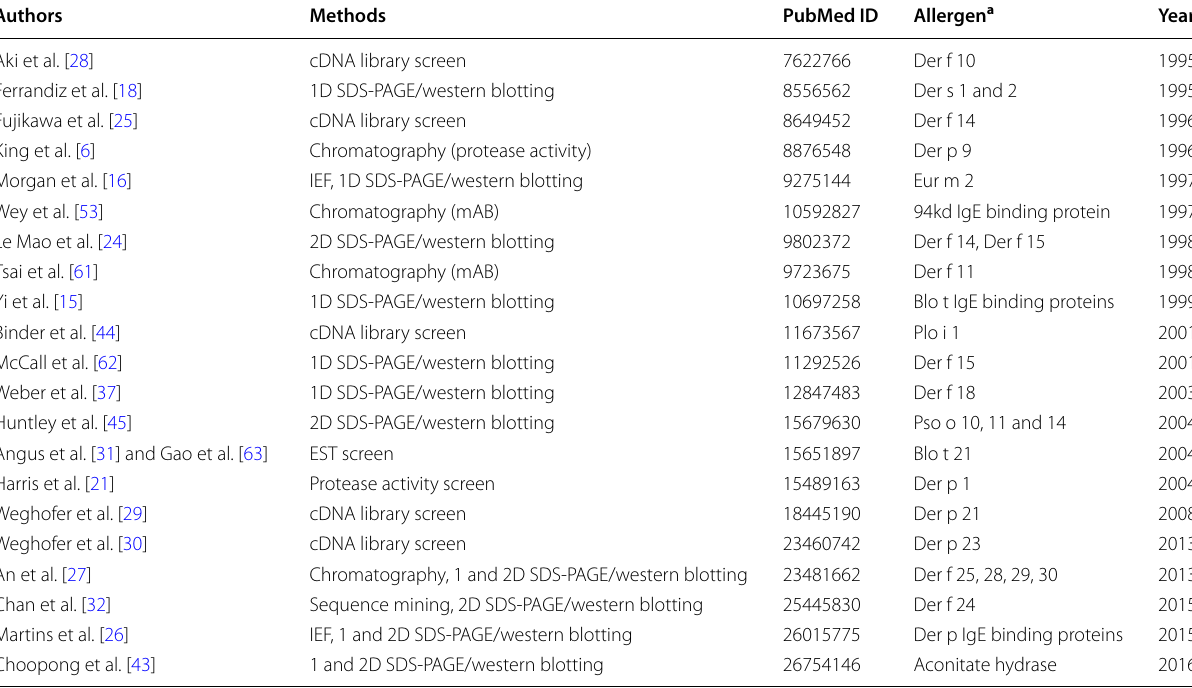
Table 1 Methods for identifying mite allergens in the discovery